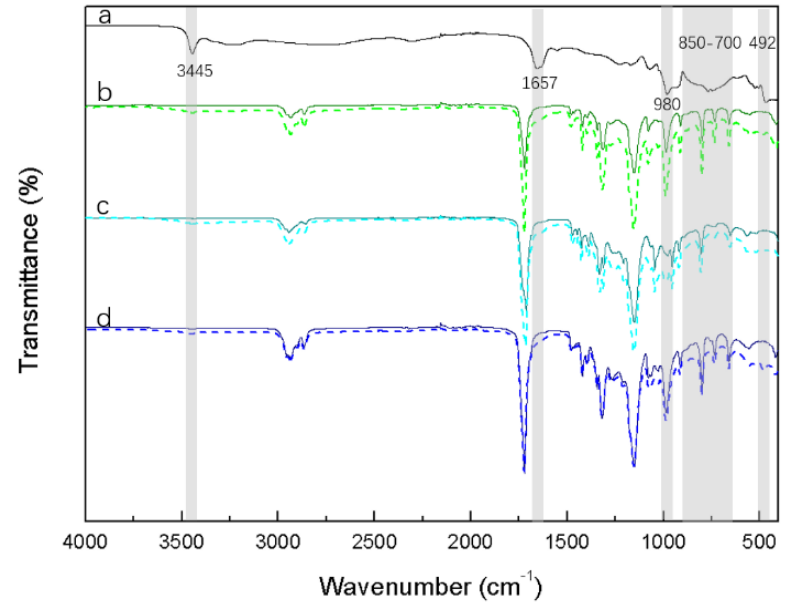
Figure 1. Attenuated total reflectance–Fourier transform infrared (ATR-FTIR) spectra of ( a ) urea phosphate (UP), ( b ) poly (hexamethylene succinate) (PHS) (solid line) and PHS_UP blend (dashed line), ( c ) poly (70% butylene succinate-co-30% hexamethylene succinate) (PBHS 70 / 30) (solid line) and PBHS 70 / 30_UP blend (dashed line), and ( d ) poly (30% butylene succinate-co-70% hexamethylene succinate) (PBHS 30 / 70) (solid line) and PBHS 30 / 70_UP blend (dashed